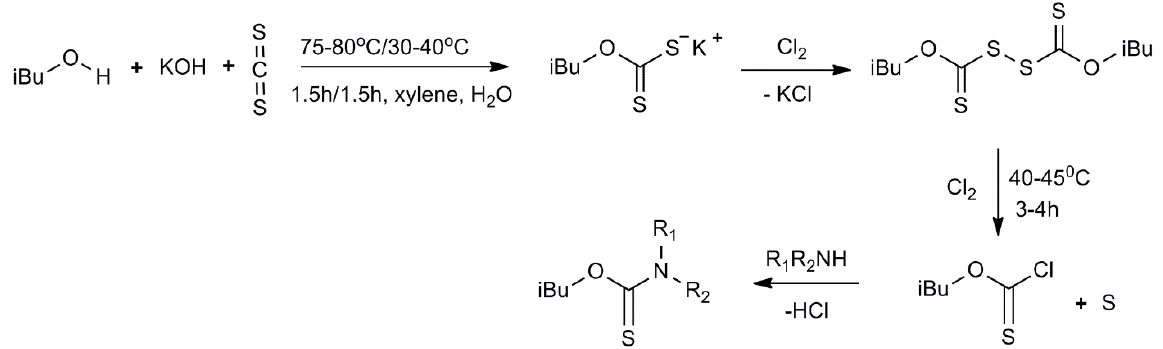
Figure 4. Chemistry of N ‐ alkyl ‐ , N , N ‐ dialkyl ‐ , and N ‐ cycloalkyl ‐ O ‐ isobutyl thiocarbamate synthesis.